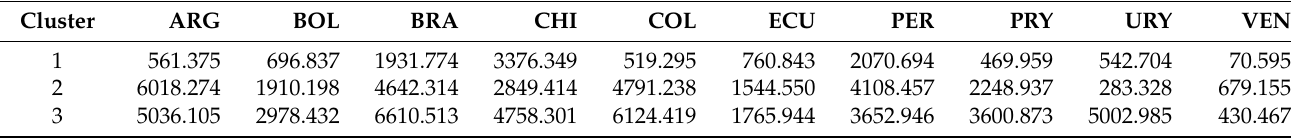
Table 9. Center of the listed cluster for the number of COVID-19 infected cases in the indicated country using the k-means method.